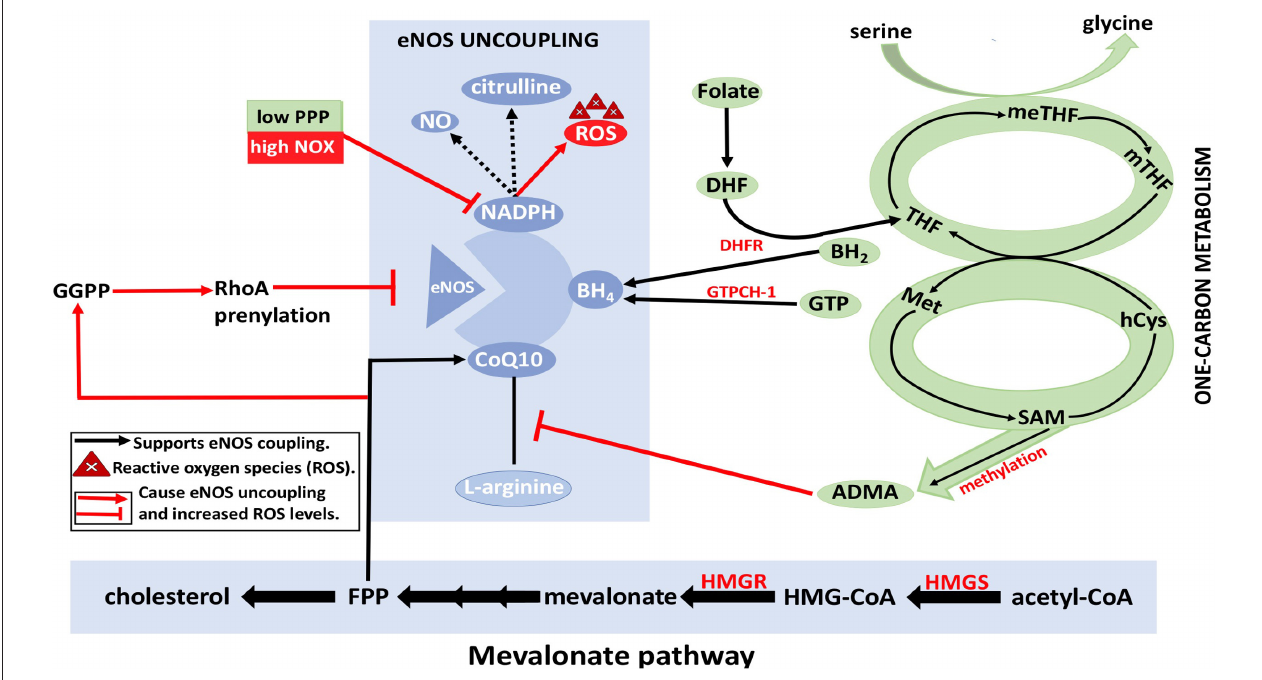
FIGURE 9 | eNOS uncoupling and Dysregulation of EC metabolism. BH 4 , NADPH, and CoQ10 are essential cofactors for eNOS coupling and synthesis of nitric oxide (NO). With the reduction in the levels of arginine and/or folate, BH4 may result in eNOS uncoupling, which in turn results in ROS formation by eNOS (instead of NO). This eventually leads to disruption of EC metabolism. Reduction in arginine reduces formation of citrulline, which results in electron that is released from NADPH to be transferred to O 2 molecules resulting in superoxide (O •− 2 ) formation. Furthermore, asymmetric dimethylarginine (ADMA) causes a reduction in eNOS activity by competing with arginine for eNOS binding. ADMA synthesis from methylation of L-arginine by methyldonor S-adenosylmethionine (SAM) in the one-carbon metabolism is shown (in green). RhoA also plays a role in eNOS inhibition by degrading eNOS mRNA transcripts. Geranylgeranyl pyrophosphate (GGPP) and farnesyl pyrophosphate (FPP) from the mevalonate pathway (in yellow) are needed for RhoA prenylation. HMG-CoA, hydroxymethylglutaryl coenzyme A; HMGR, 3-hydroxy-3-methylglutaryl-CoA reductase; MET, methionine; MTHFR, methylenetetrahydrofolate reductase; SMA, S-adenosylmethionine; C0Q10, coenzyme Q10; ADMA, asymmetrical dimethyl arginine; NADPH, nicotinamide adenine dinucleotide phosphate; THF, tetrahydrofolate; PPP, pentose phosphate pathway; meTHF; 5,10-methylene-methyltetrahydrofolate; GTPCH, GTP cyclohydrolase; BH4, tetrahydrobiopterin; FPP, farnesylpyrophosphate; NOX, NADPH oxidase; Acetyl-CoA, acetyl-coenzyme A; hCYS, homocysteine; mTHF, 5 methyltetrahydrofolate; DHF, dihydrofolate; GGPP, geranylgeranyl pyrophosphate; HMGS, 3-hydroxy-3-methylglutaryl-CoA synthase; DHFR, dihydrofolate reductase; BH2, 7,8dihydrobiopterin; NO, nitric oxide; eNOS, endothelial nitric oxide